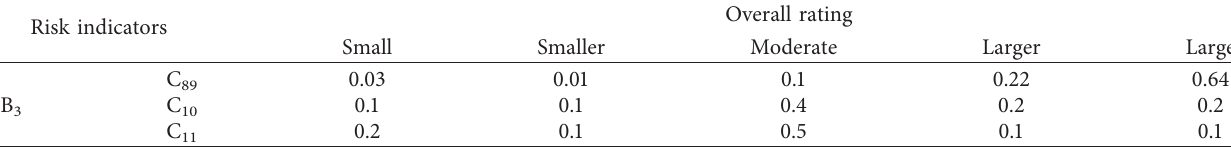
Table 6: Probability distribution of the 1st superimposed parallel risk level.